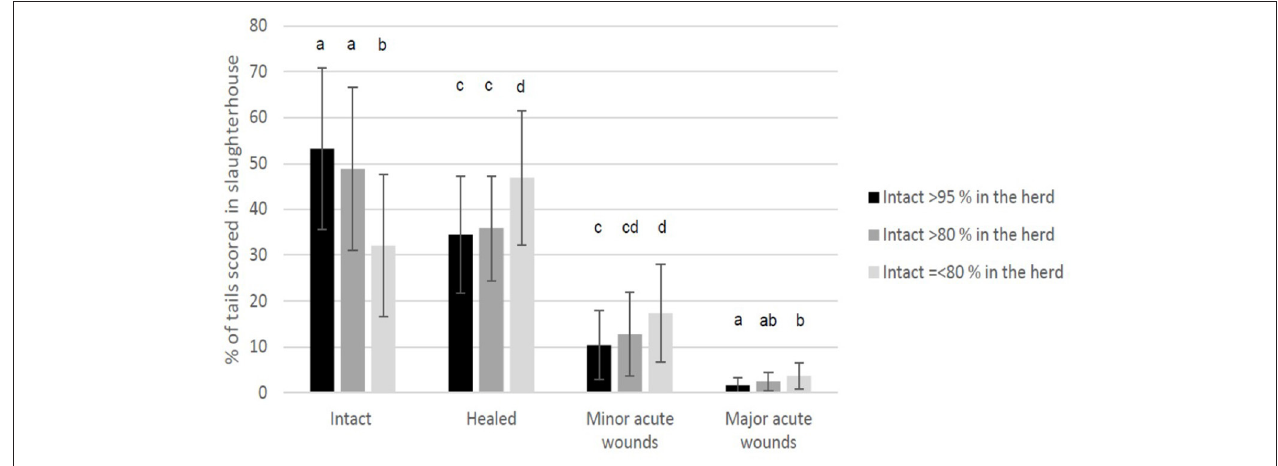
FIGURE 4 | The average percentage of undocked tails of finishing pigs per herd ( n = 84) scored at the slaughterhouse in four categories (intact, healed, with minor acute wounds, and with major acute wounds) and divided according to the evaluation of the percentage of intact tails recorded during the herd health visits ( > 95%, > 80%, or ≤ 80%). Within tail score comparisons, different letters represent statistical significance: ab p < 0.01, cd p < 0.05.